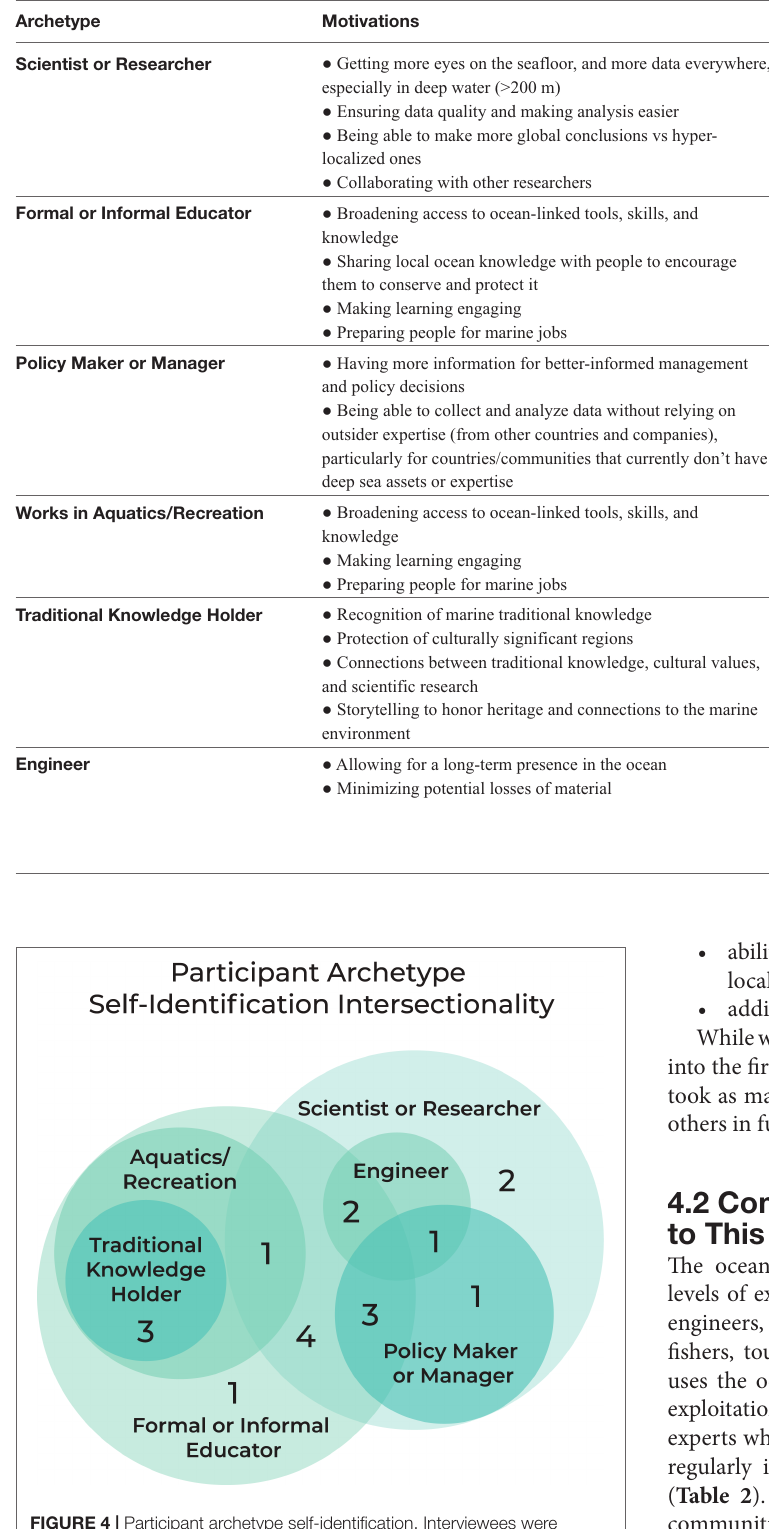
TABLE 1 | Interviewee archetypes, motivations, and requirements, listed in order of frequency.